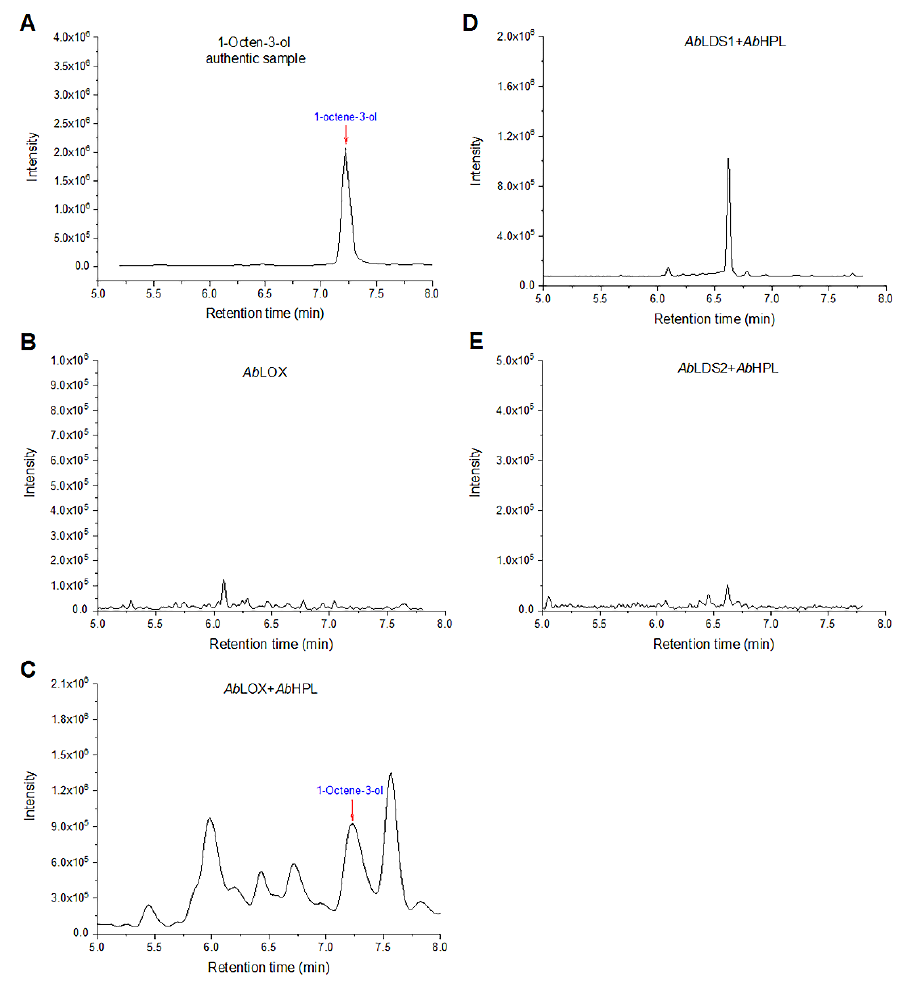
Figure 1. GC-MC analysis chromatogram of 1-octen-3-ol production in the enzymatic linoleic acid reaction. ( A ) Authentic sample of 1-octen-3-ol. ( B ) Enzymatic reaction by Ab LOX. ( C ) Enzymatic reaction by Ab LOX + Ab HPL. ( D ) Enzymatic reaction by Ab LDS1 + Ab HPL. ( E ) Enzymatic reaction by Ab LDS2 + Ab HPL.